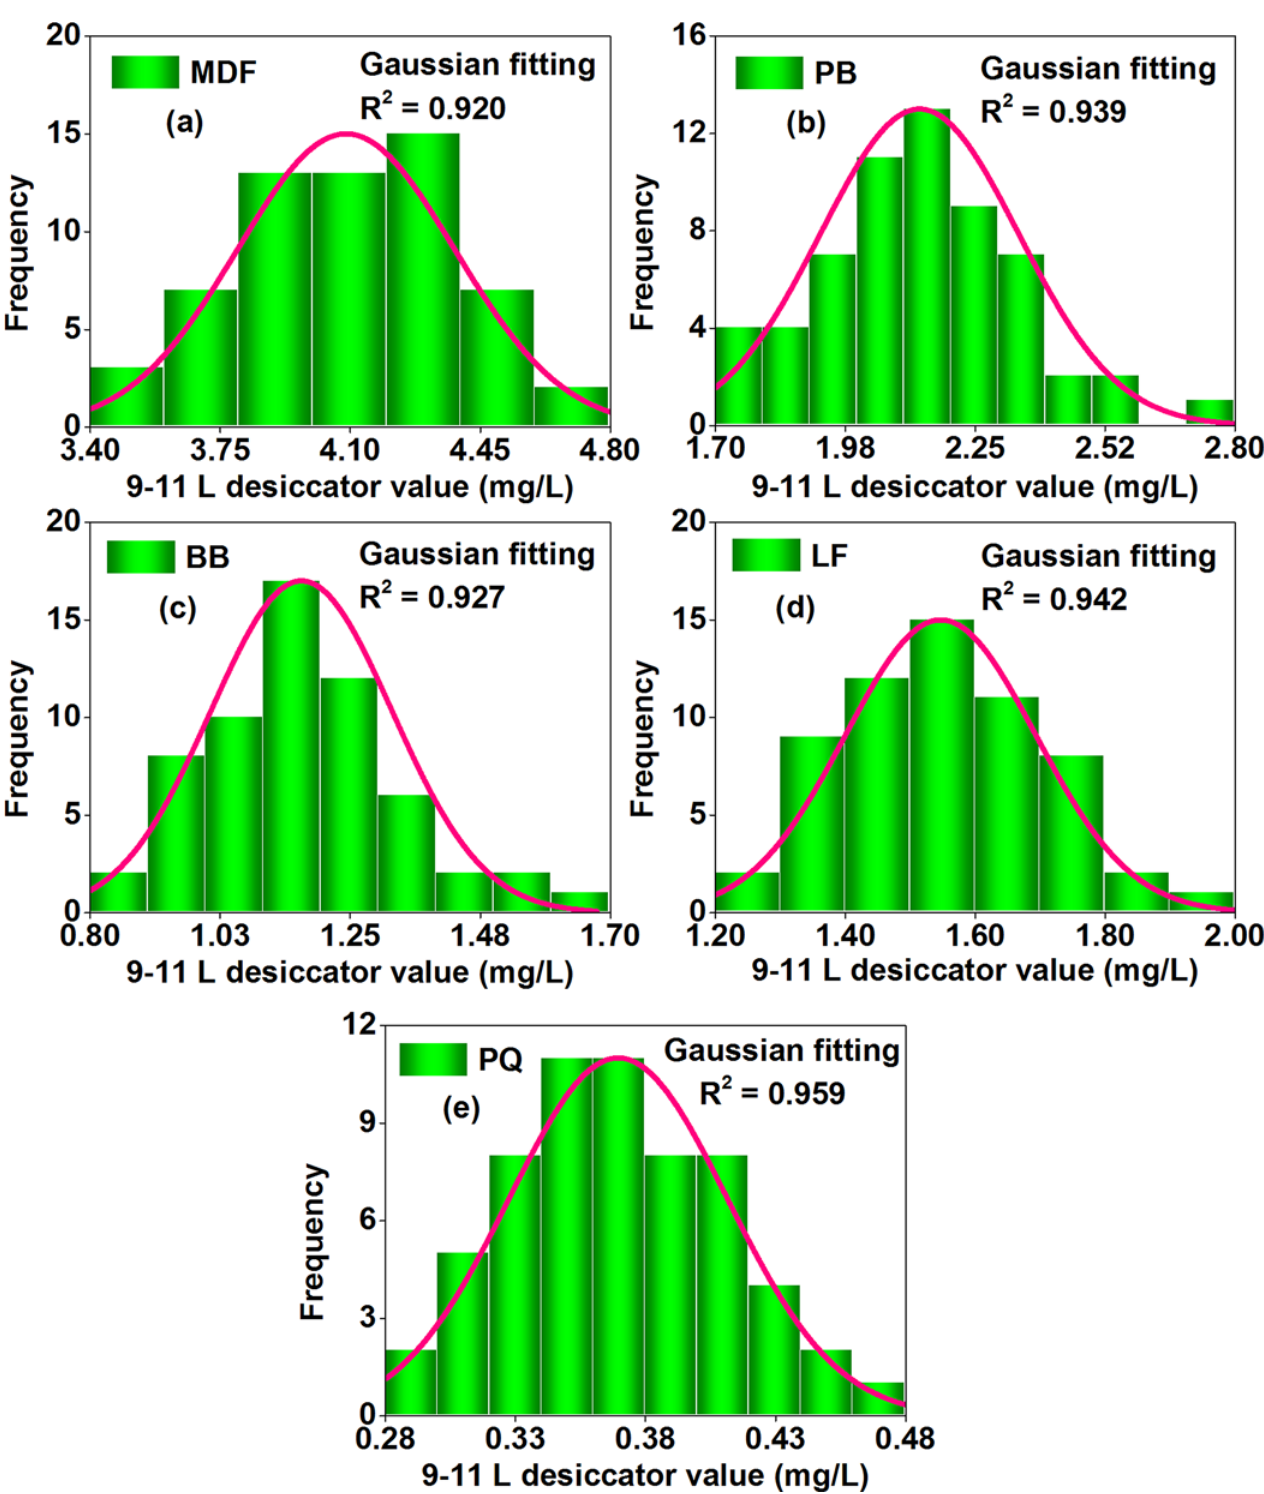
Fig 9. Statistical distributions of formaldehyde emission values (9 – 11 L desiccator value, derived from multiple tests) of various materials characterized by the 9 – 11 L desiccator method of the Chinese national standard GB 18580. (a) MDF, medium density fiberboard. (b) PB, particleboard. (c) BB, blockboard. (d) LF, laminate flooring. (e) PQ, parquet. The frequency denoted the number of data occurred at corresponding emission formaldehyde levels. These data were fitted by the probability density function of a Gaussian